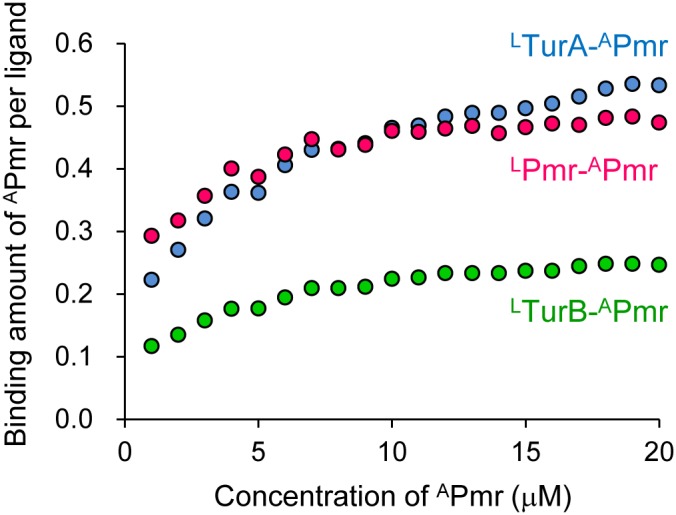
Coupling ratios of Pmr-Pmr, TurA-Pmr, and TurB-Pmr oligomers.The figure presents the binding amount of APmr per one homodimer of LPmr (pink), LTurA (blue), and LTurB (green) as a function of the concentration of APmr (µM). The immobilized amount of LPmr, LTurA, and LTurB were 530 RU, 540 RU, and 540 RU, respectively. To calculate the binding amount of APmr per one homodimer of the ligands, the equilibrium binding response (R
eq) was divided by the amount of immobilized LPmr, LTurA, and LTurB.